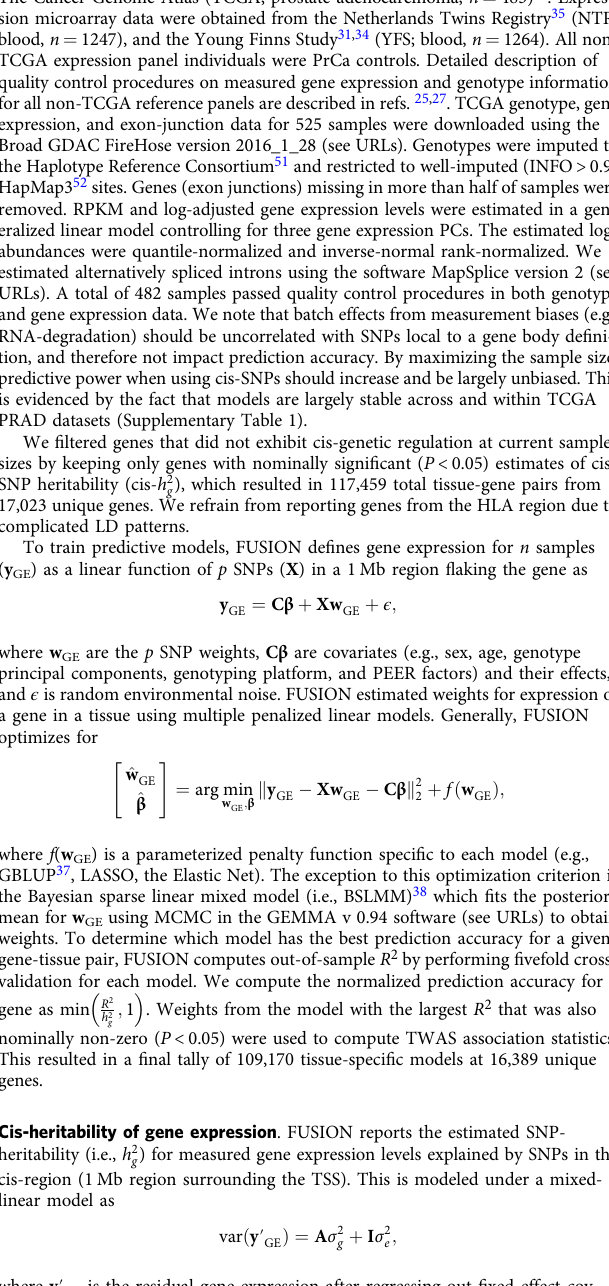
some level (e.g., r 2 > 0.5).